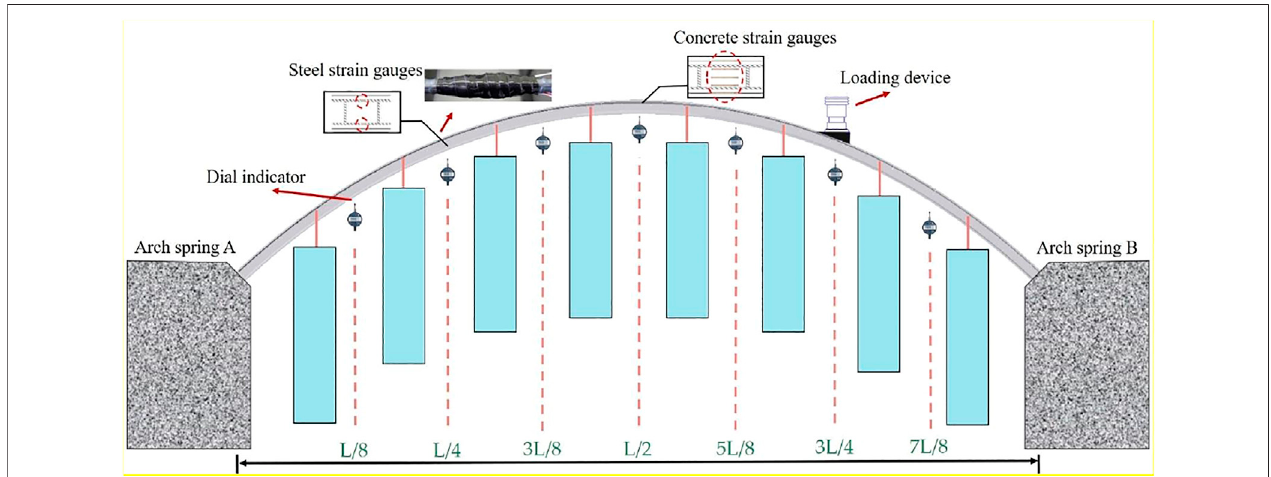
FIGURE 6 | Arrangement of measuring points and the loading